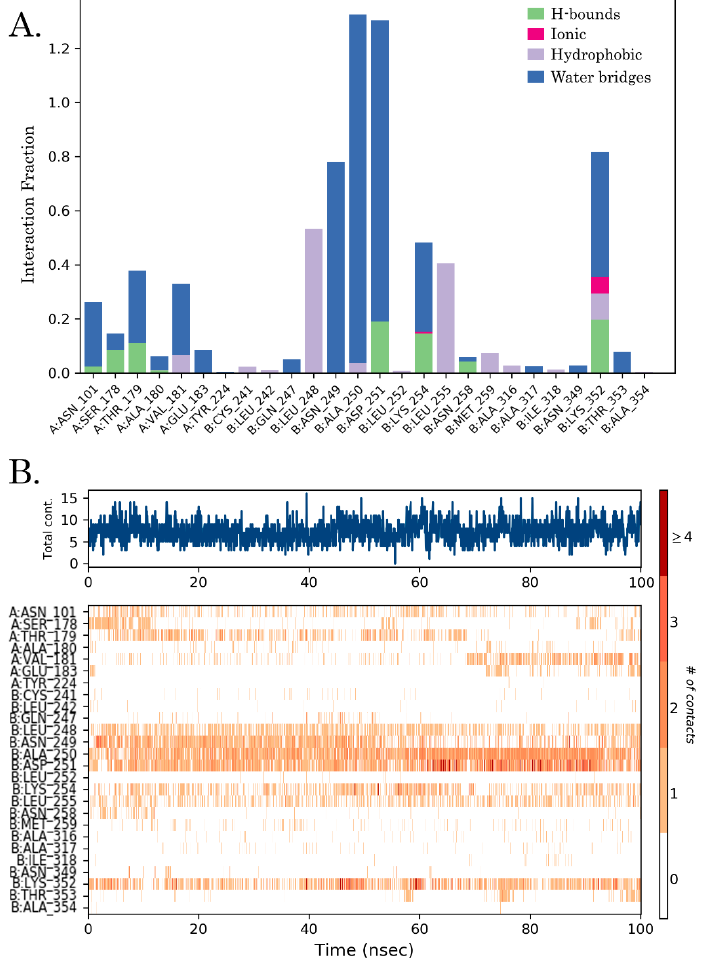
Figure 8. ( A ) Protein-ligand fraction interaction diagram between EAPC-67 and tubulin. H-bonds, ionic, hydrophobic interactions, and water bridges are shown in green, red, purple, and blue, respectively. ( B ) Contact points of EAPC-67 and amino acids of colchicine binding site during the whole simulation trajectory. The top panel shows the total number of protein-ligand contacts over 100 ns.